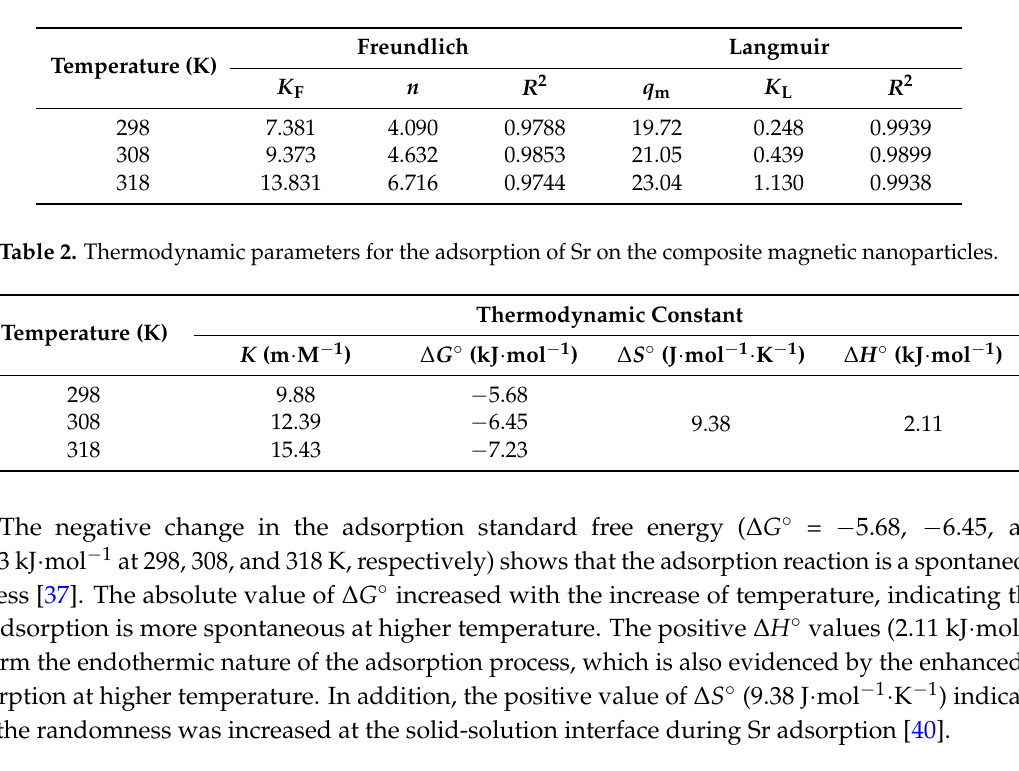
Figure 7. Plot of ln K vs. 1/ T for the estimation of the thermodynamic parameters for the adsorption of Sr on the composite magnetic nanoparticles. Table 1. Parameters of the Freundlich and Langmuir adsorption isotherm models for Strontium (Sr) on the composite magnetic nanoparticles.